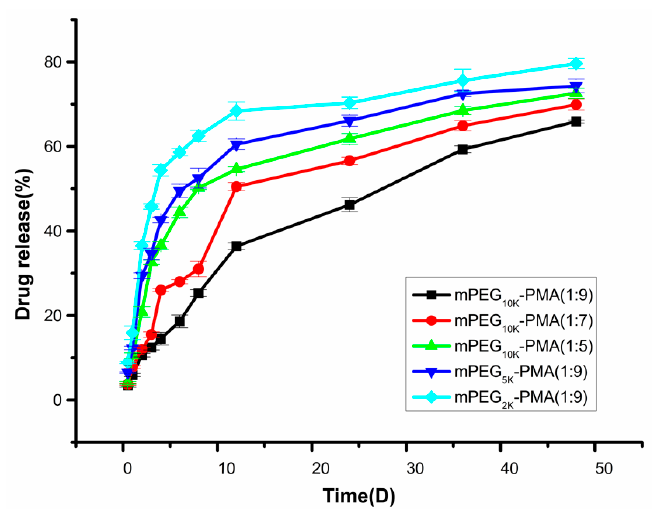
Figure 4. Cumulative release curves of drug-loaded microspheres in vitro.